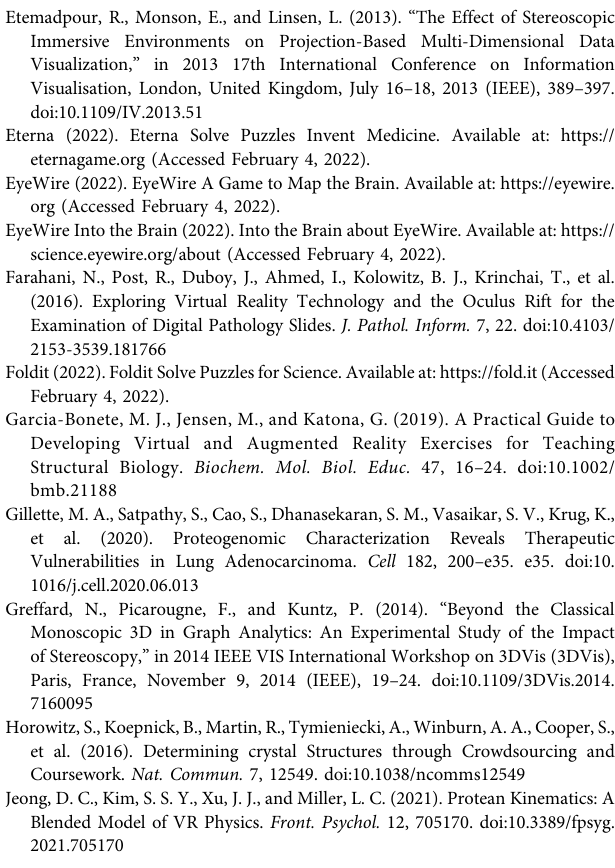
Figueiredo, E. G. (2016). Virtual and Stereoscopic Anatomy: when Virtual Reality Meets Medical Education. J. Neurosurg. 125, 1105 – 1111. doi:10.3171/ 2015.8.JNS141563 Doak, D. G., Denyer, G. S., Gerrard, J. A., Mackay, J. P., and Allison, J. R. (2020). Peppy: A Virtual Reality Environment for Exploring the Principles of Polypeptide Structure. Protein Sci. 29, 157 – 168. doi:10.1002/pro.3752 Eiben, C. B., Siegel, J. B., Bale, J. B., Cooper, S., Khatib, F., Shen, B. W., et al. (2012). Increased Diels-Alderase Activity through Backbone Remodeling Guided by Foldit Players. Nat. Biotechnol. 30, 190 – 192. doi:10.1038/nbt. 2109 Ellis, S. R., Tharp, G. K., Grunwald, A. J., and Smith, S. (1991).